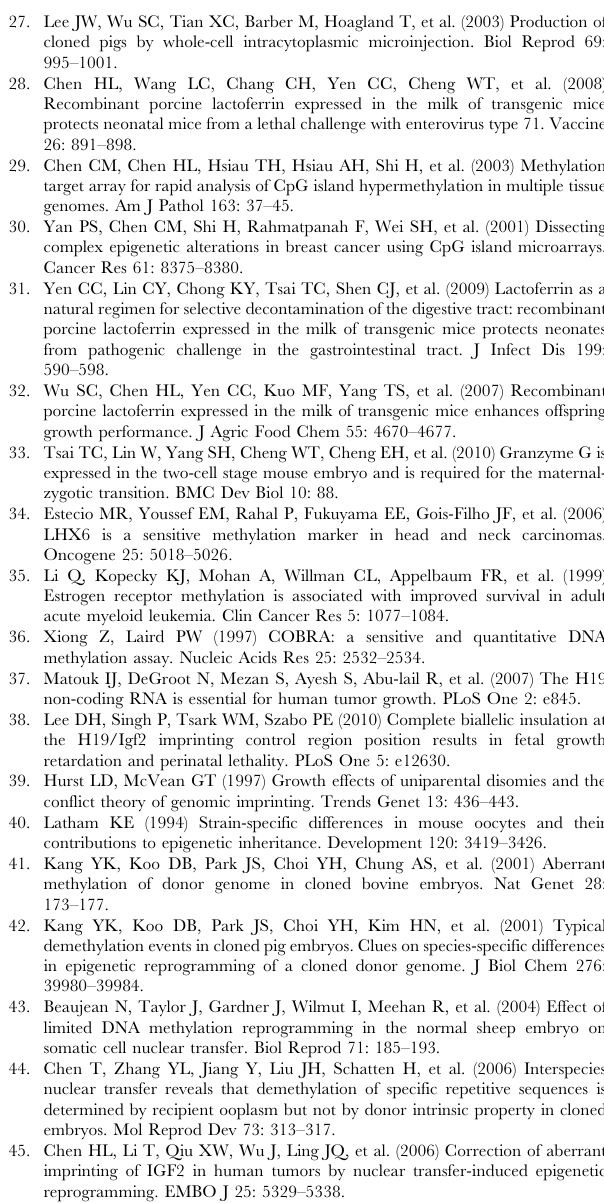
Table S8 The percentage of aberrant methylation of the four imprinted genes in all analyzed tissues of the four cloned